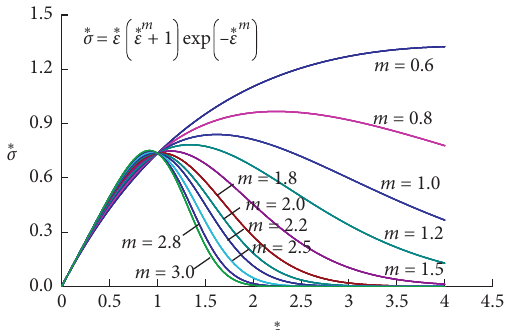
Figure 6: The schematic diagram of E and 􏽥 E with the determining